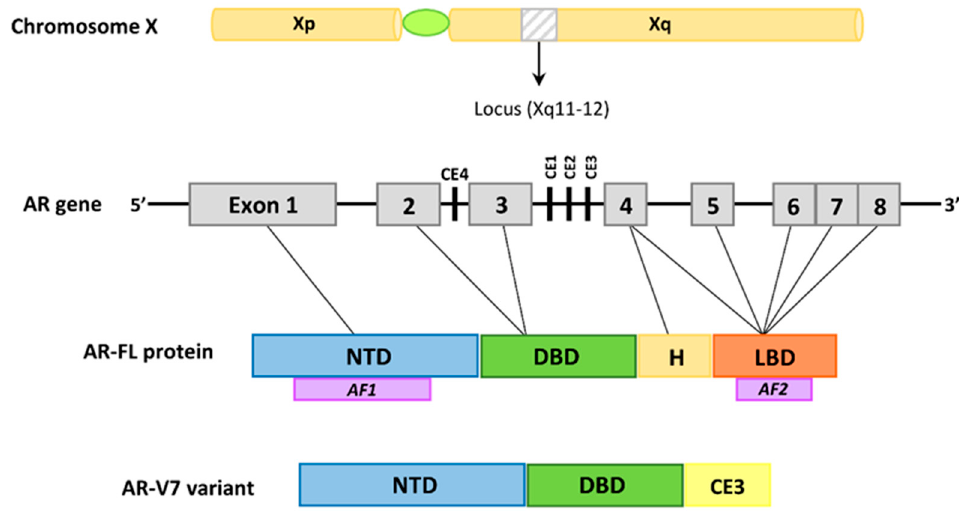
Figure 1. The structure of the AR-FL and AR-V7 variants. The AR gene is located on the X chromo- some (Xq11-12) and it is composed of 8 exons. Exon 1 encodes the amino-terminal domain (NTD), which contains the AF1 activating domain. Exons 2 and 3 encode the DNA-binding domain (DBD). The 5 (cid:48) region of exon 4 forms the hinge (H) region, which contains the nuclear localization signal, whereas the 3 (cid:48) region of exon 4 and exons 5–8 encode the ligand-binding domain (LBD),